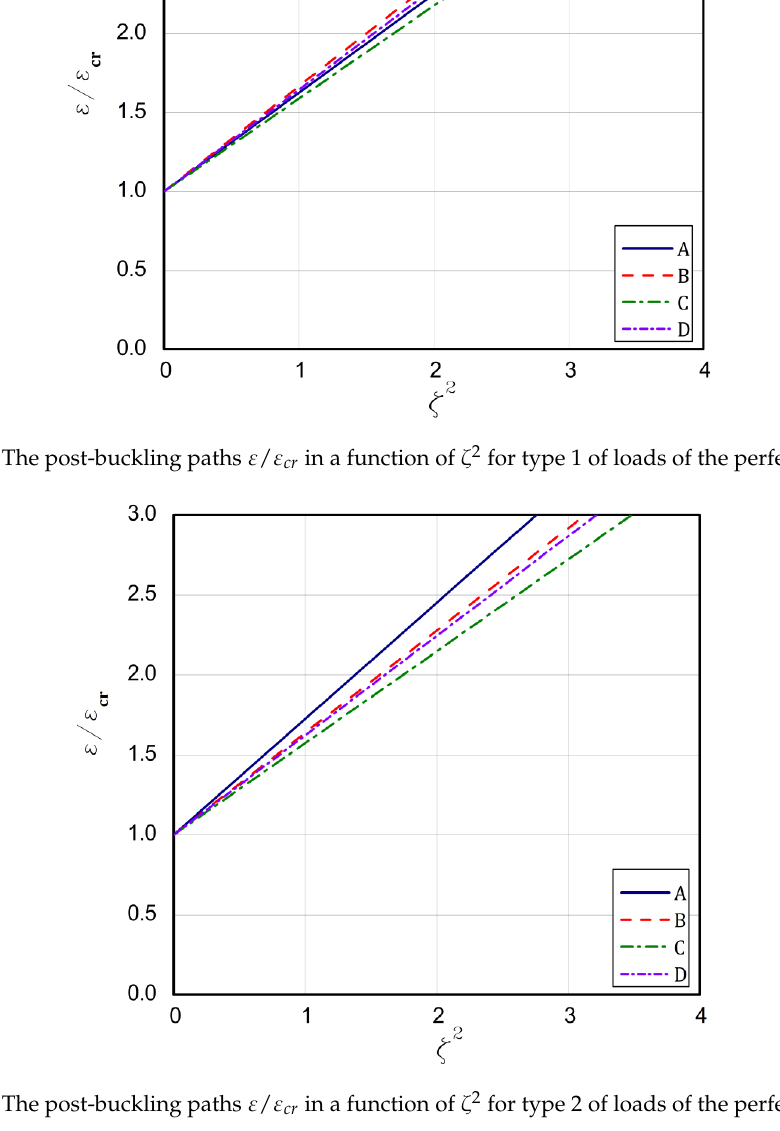
Figure 4. The post-buckling paths The post-buckling paths for the perfect plates (i.e., for ζ